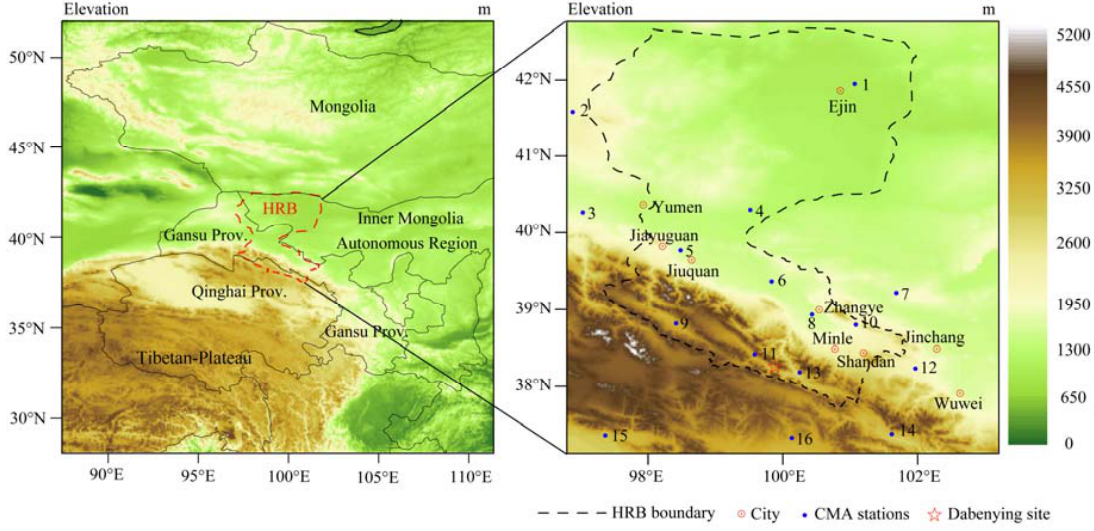
Figure 1. Study region and observation sites. The blue dots represent the locations of the China Meteorological Administration (CMA) stations. The numbers 1–16 represent the following station IDs: 52267, 52378, 52436, 52446, 52533, 52546, 52576, 52633, 52645, 52652, 52657, 52661, 52674, 52737, 52754, and 52765, respectively.